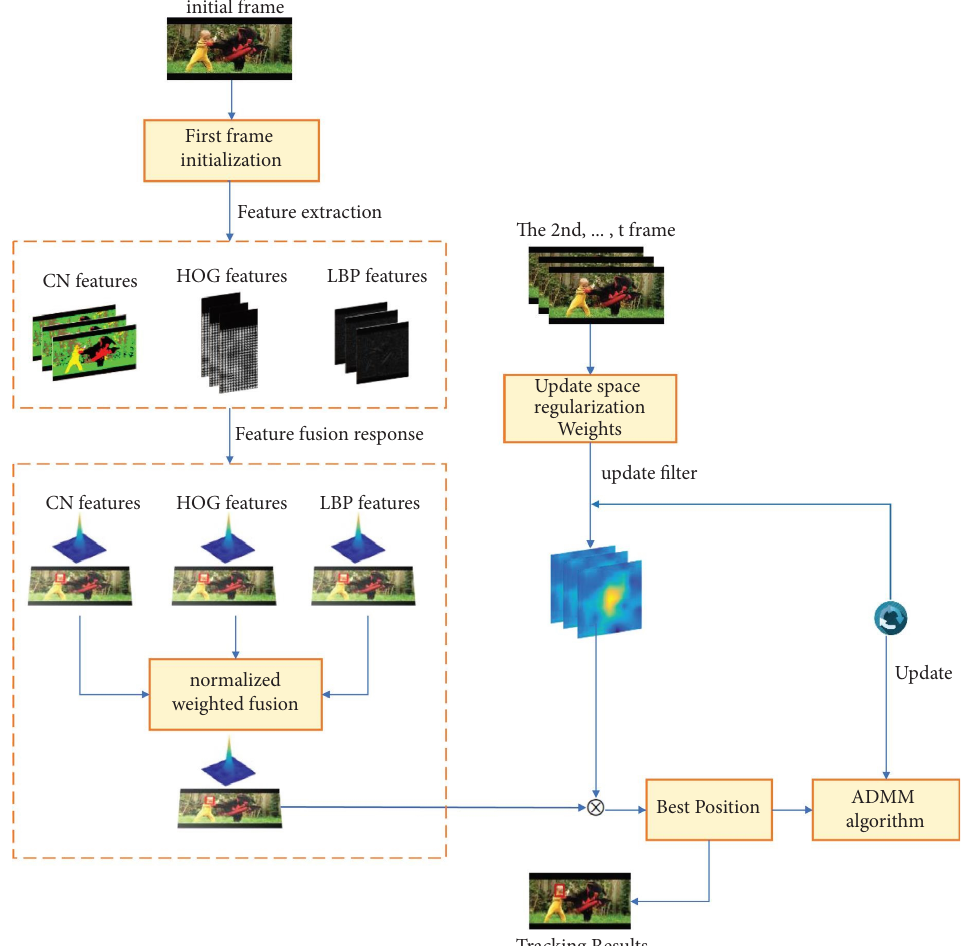
Figure 2: Te overall framework of the algorithm in this